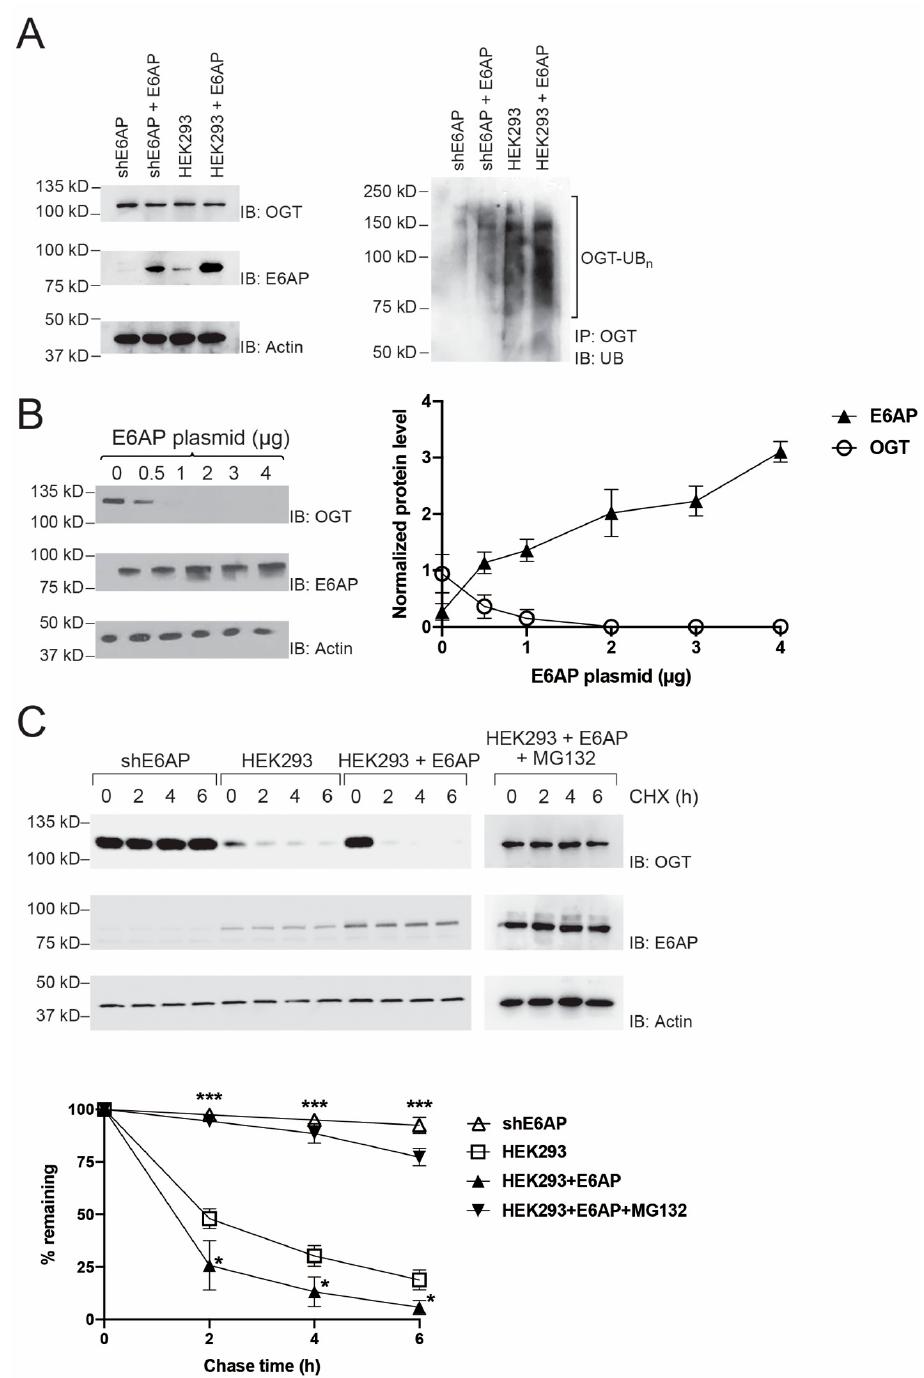
Figure 2. E6AP-catalyzed OGT ubiquitination and regulation of OGT stability in HEK293 cells. ( A ) Enhanced OGT ubiquitination with forced expression of E6AP in HEK293 cells. Left panels show inhibition of E6AP expression by anti-E6AP shRNA (shE6AP), and E6AP expression was restored by transfection of the plvx-E6AP plasmid into the shE6AP cells (shE6AP + E6AP). Additionally, HEK293 cells transfected with plvx-E6AP (HEK293 + E6AP) showed a higher level of E6AP expression than the blank cells (HEK293). The right panel shows the ubiquitination of OGT was enhanced with forced E6AP expression in the cells. The cells were treated with proteasome inhibitor MG132 for 4 h before the cell lysates were prepared for immunoprecipitation of OGT with an anti-OGT antibody. The precipitated samples were analyzed by SDS-PAGE and Western blotting with an anti-UB antibody. Ubiquitination of OGT was compared among HEK293 expressing shE6AP (shE6AP), HEK293 expressing both shE6AP and recombinant E6AP (shE6AP + E6AP), blank HEK293 cells (HEK293),